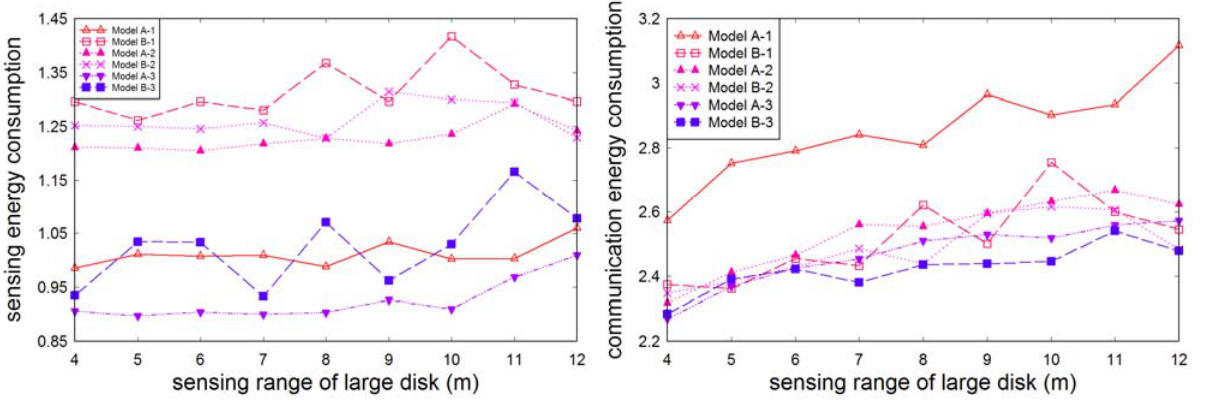
Figure 6. Energy variations with different sensing range ( N = 1,000).